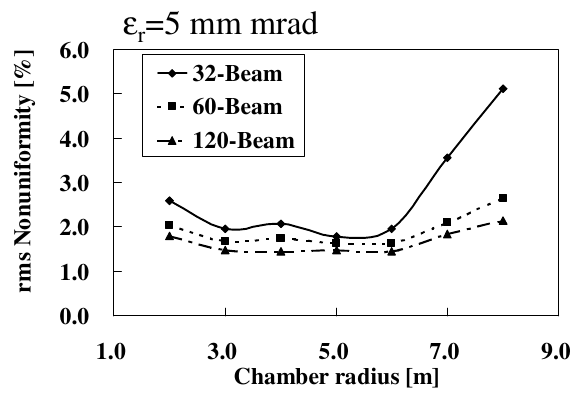
FIG. 10. The chamber radius versus the rms nonuniformity in the cases of the Al layer target with the semi-Gaussian dis- tribution including the beam temperatures for the 32, 60, and 120-beam systems.